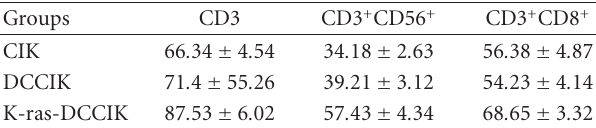
Table 2: Surface marker of CIK and DCCIK induced by antigens ( % , X ± SD, n = 6) . Groups